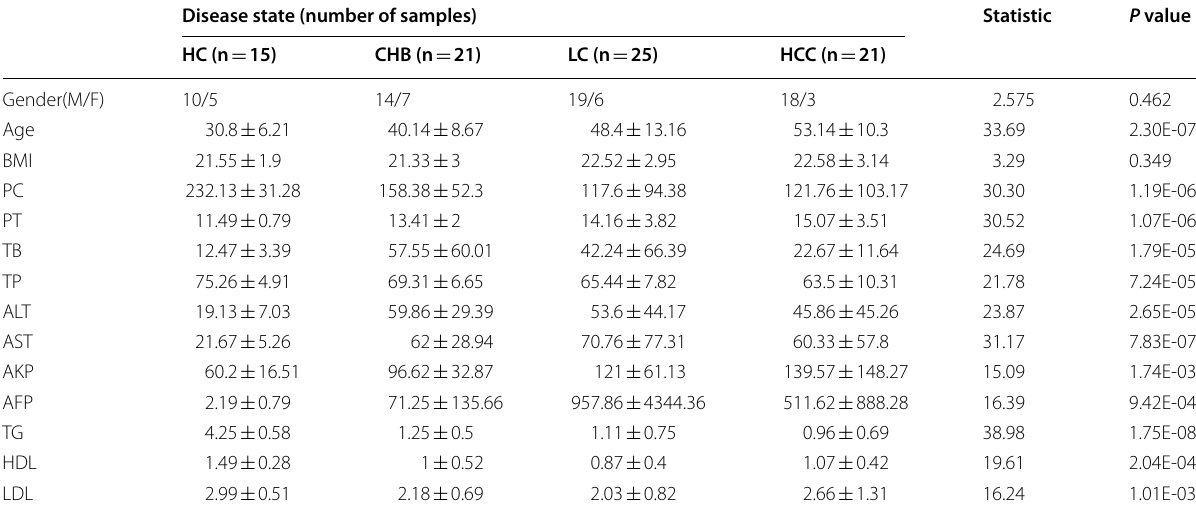
Continuous variables were expressed as mean standard deviation. Chi-square test was used for gender, and Kruskal–Wallis test was used for other clinical variables ± NA indicated not